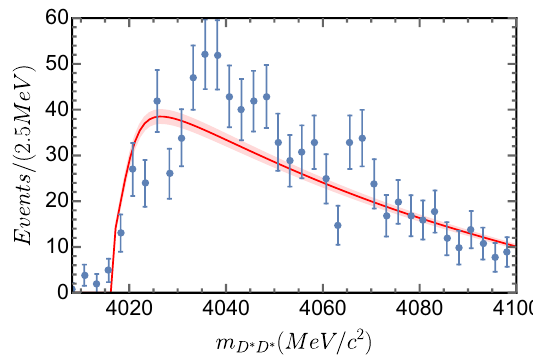
(cid:112) s = 4.26 GeV. Experimental data are from Figure 2: Line shape for D ∗ ¯ D ∗ at Refs. [ 35 ] . The theoretical line shapes have been convoluted with the experimen- tal resolution. The line-shape’s 68%-uncertainty is shown as a shadowed